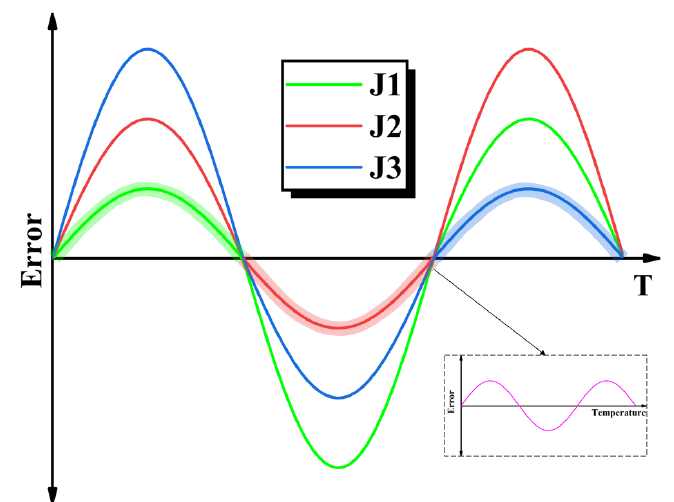
Figure 10. Schematic diagram of the multi-junction precision calibration method.